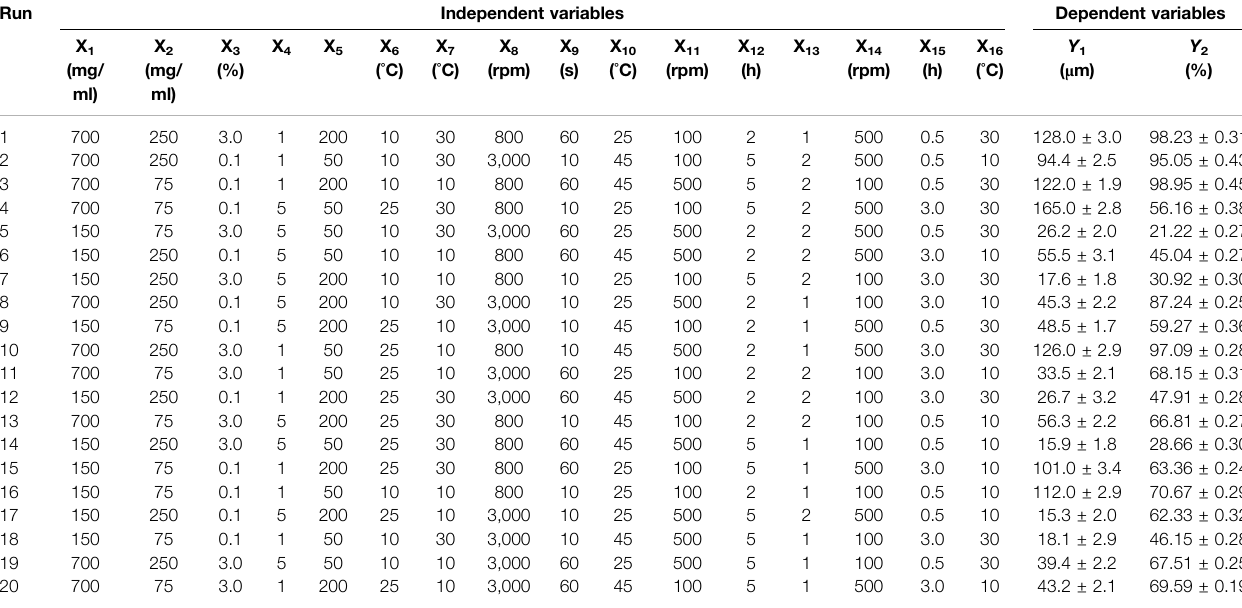
TABLE 4 | Plackett – Burman experimental design and the observed responses. Run Independent variables Dependent